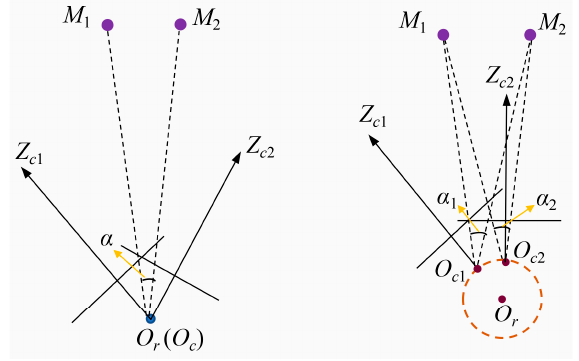
Figure 13. Schematic